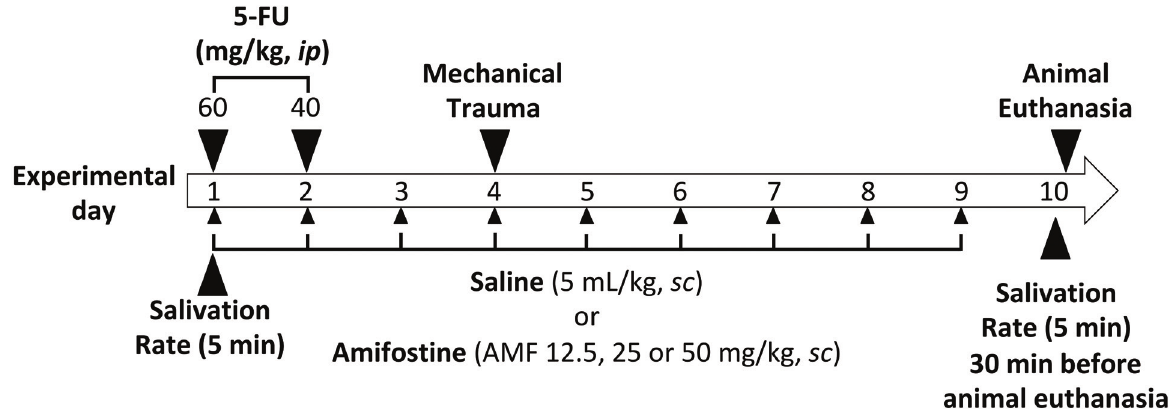
Figure 1. Schematic diagram of the experimental